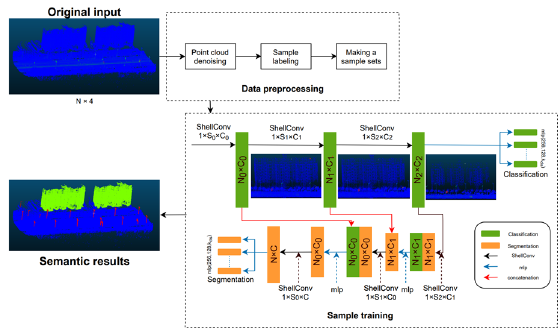
Figure 2. Technology Roadmap. For the input point cloud, pre- processing is first performed, including point cloud denoising, sample set labeling, and generation, where N is the number of raw point clouds, and XYZ coordinates and intensity are the four feature inputs for the point. Entering the ShellNet network, through three layers of ShellConv, a matrix of size N 2 × C 2 is obtained, where N 2 is the number of representative points that are finally extracted from the input point cloud. Each point contains a high-dimensional feature vector of size C 2 . This matrix is entered into the mlp module, size (256, 128), to generate a probability plot for object